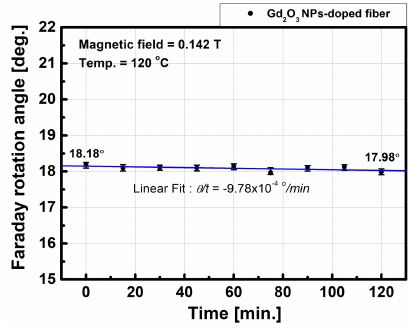
Figure 7. Variation of the FRA as function of the time under 0.142 T at 120 ◦